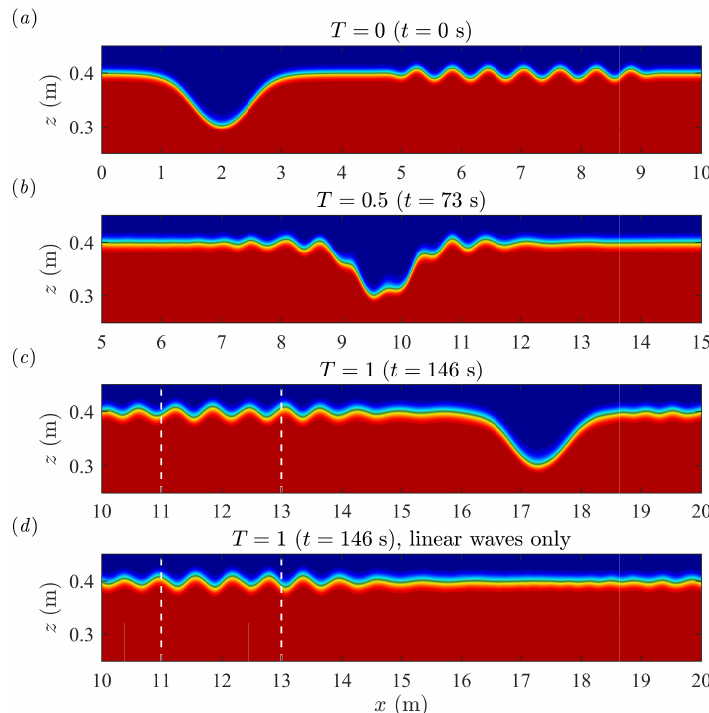
Figure 5. Same as Fig. 4 but for O6. Vertical lines in panels (c) and (d) show the misalignment of wave crests in the two density